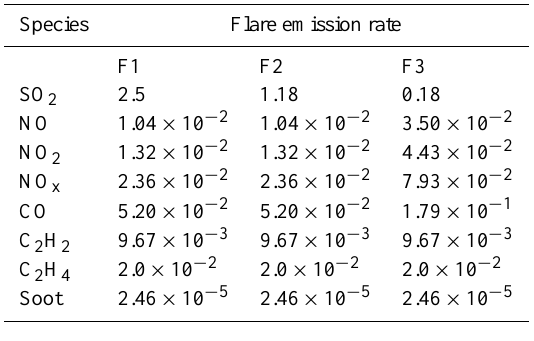
Table 4. Mass flow rates used in WRF-Chem for the three flares at MHR in Tula. Units are in kgs − 1 .